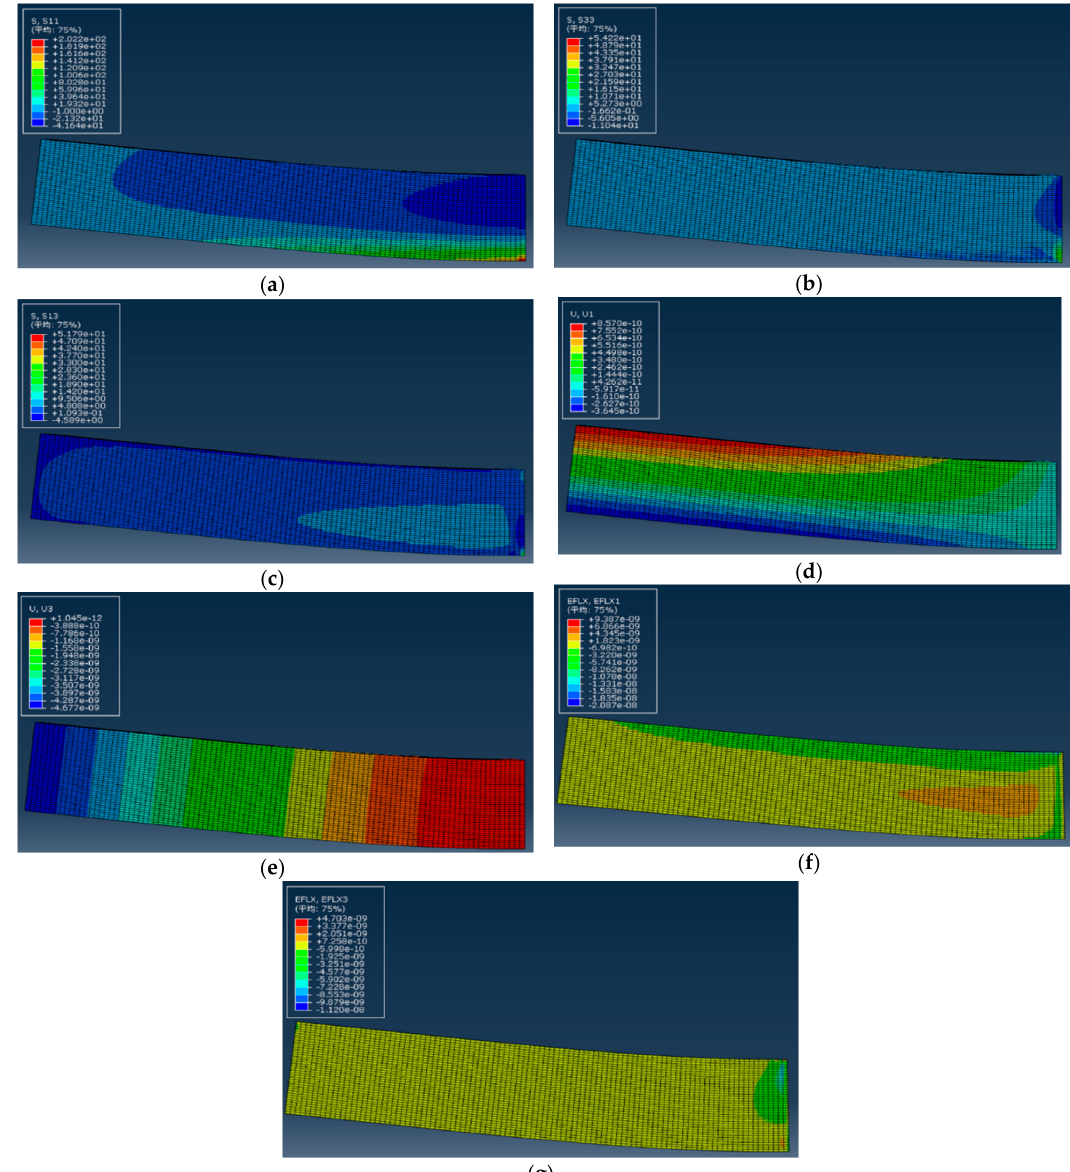
Figure 6. Cloud diagrams of mechanical stresses and displacements, and electrical displacements: ( a ) The cloud diagram of σ x ; ( b ) The cloud diagram of σ z ; ( c ) The cloud diagram of τ xz ; ( d ) The cloud diagram of u ; ( e ) The cloud diagram of w ; ( f ) The cloud diagram of D x ; ( g ) The cloud diagram of D z .